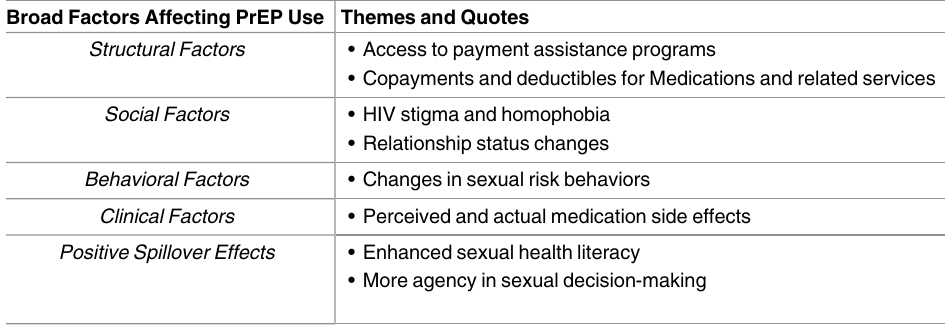
Table 1. Primary results